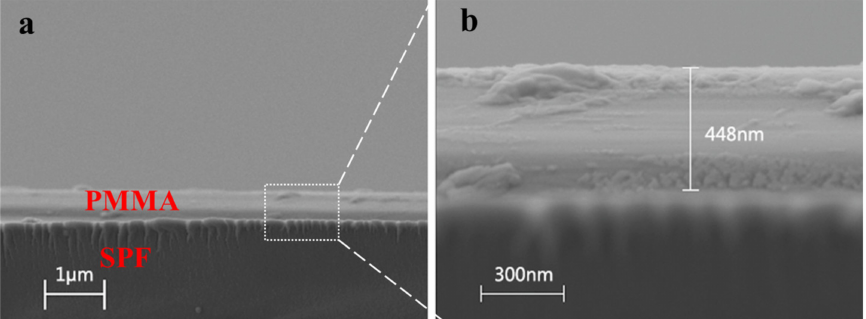
Figure A2. The thickness of PMMA. The SEM images of PMMA in 1 µ m ( a ) and 300 nm ( b ) scales, showing the PMMA thickness is approximately 448